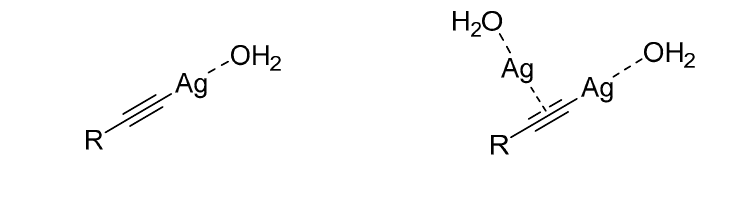
Figure 2. Formation of Ag(I)-acetylide species in water.